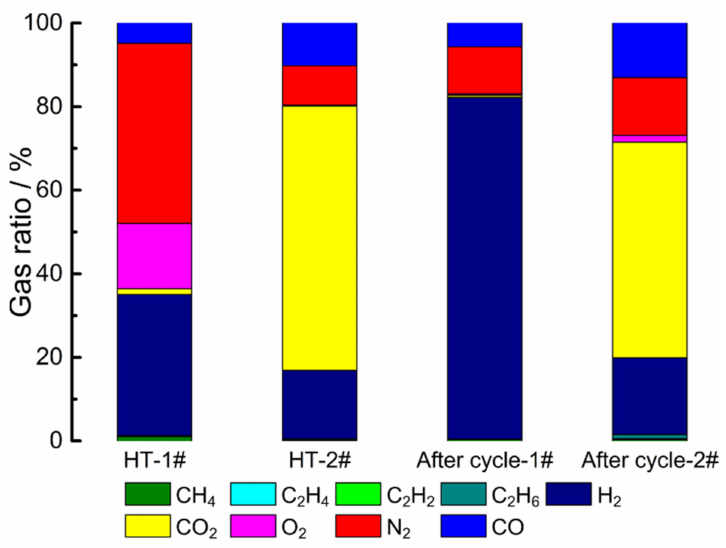
Figure 9. The gas composition of AC/AC EDLC at different states (HT: high